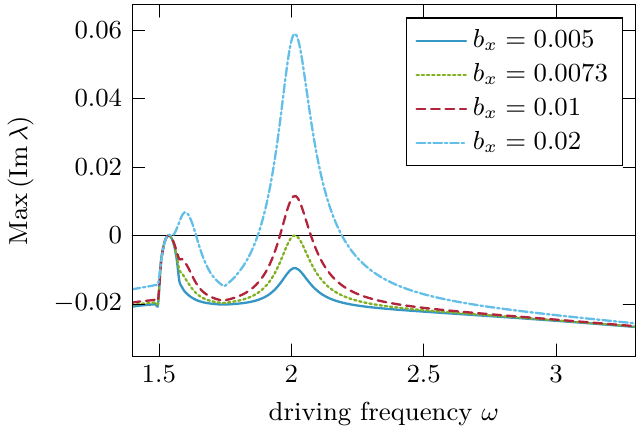
] as a function of driving frequency ω obtained by diag- Figure 6: Largest Im [ λ k onalizing the 18x18 matrix M F at the momentum of the leading instability, see Eq. (21) and Fig. 5, for increasing amplitudes of linearly polarized driving field = N = 1 / 3). For small oscillating fields, b ( c = 0.71, δ = 1.76, α = 0.03, N x x y < 0.0073 the system is stable for all frequencies, while it becomes unstable b x ] > 0) for larger fields, first close to the resonant frequencies. Further in- (Im [ λ k creasing the amplitude of the driving field increases the range of frequencies where instabilities